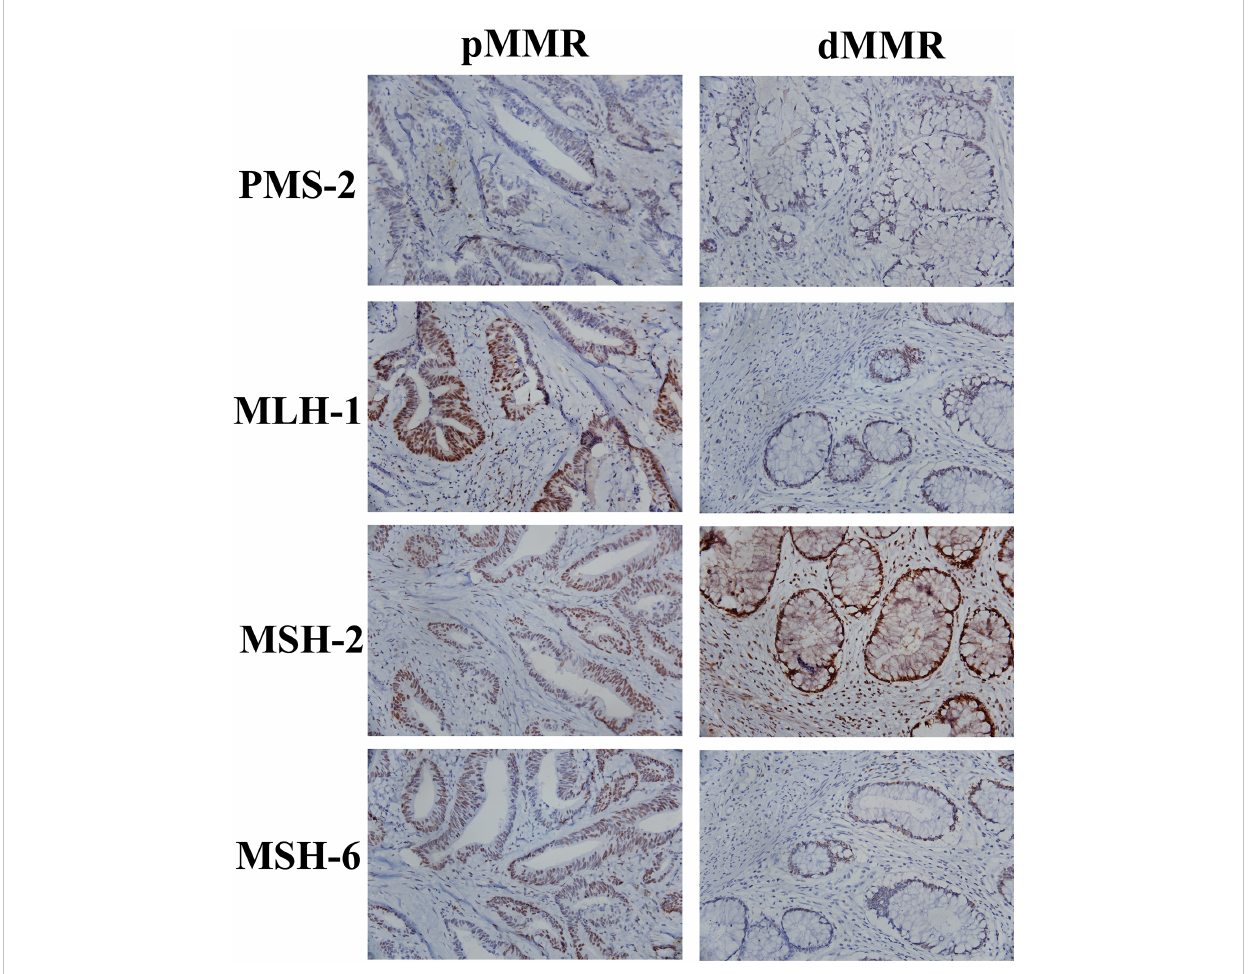
FIGURE 4 Pathological sections of tumor specimens from patients with pMMR and dMMR